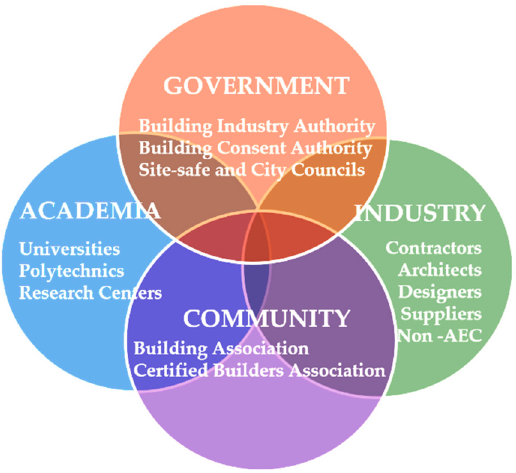
Figure 7. BIM innovation